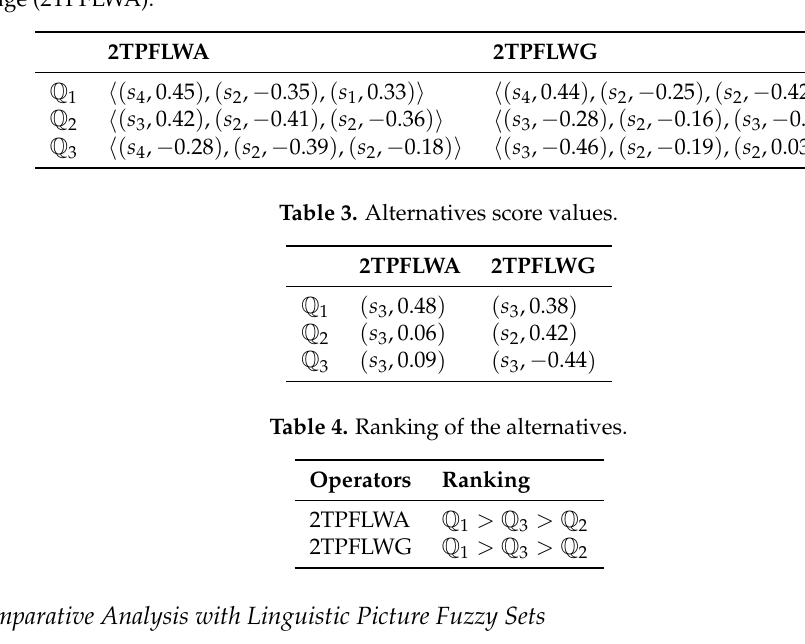
Table 2. The aggregated value of the alternatives by using the 2-tuple picture fuzzy linguistic weighted average (2TPFLWA).